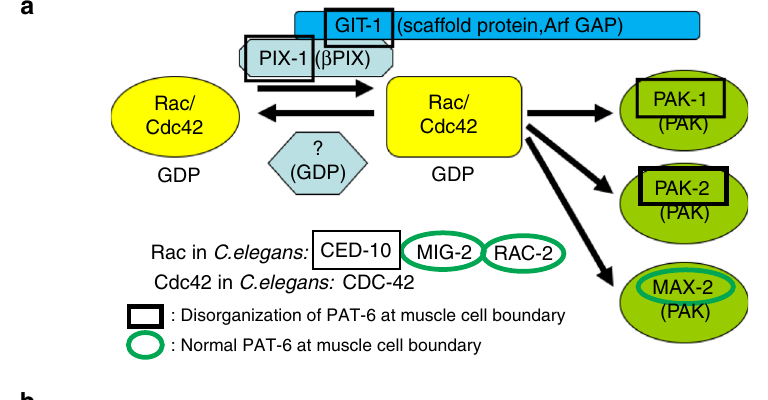
Fig. 6 Antibodies to PIX-1 detect PIX-1a on a western blot and localize to muscle cell boundaries, M-lines, and dense bodies. a Schematic representation of domains in the predicted isoforms PIX-1a and PIX-1b and regions used as immunogens to generate antibodies. b Western blot detection of a protein of expected size for PIX-1a from wild type and from pix-1(gk893650) [P190S] but not from deletion or nonsense pix-1 mutants. Anti-paramyosin was used as a gel loading control. An image of the entire blot reacted with anti-paramyosin is available in the Source Data Files. c Antibodies to PIX-1 localize to muscle cell boundaries and with less intensity to M-lines and dense bodies. Each strain was co- stained with antibodies to PAT-6 and PIX-1, and imaged by confocal.